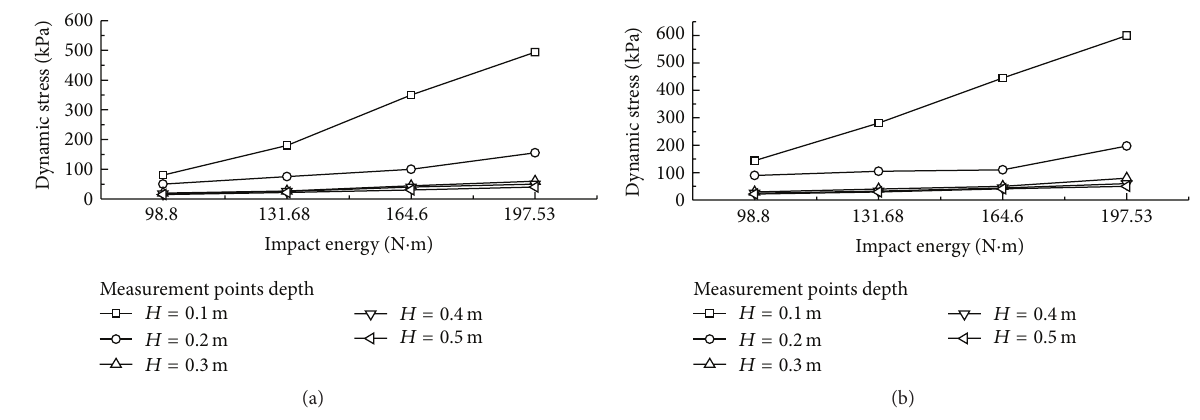
Figure 8: Relationship of peak dynamic stress to impact energy: (a) first impact, (b) second